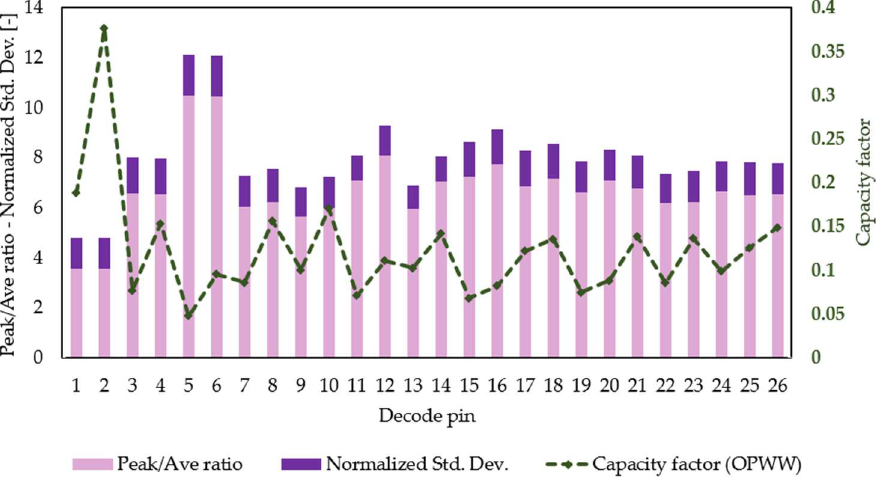
Figure 8. Results obtained after performing the permutation logic detailed in Table 3.